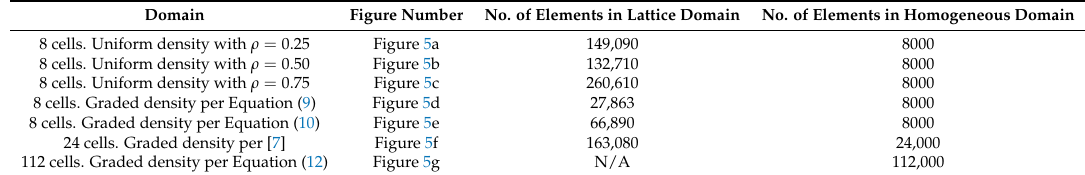
Table 3. Number of elements in FE meshes of lattice and simplified homogeneous domains. Domain Figure Number No. of Elements in Lattice Domain No. of Elements in Homogeneous Domain 8 cells. Uniform density with ρ =